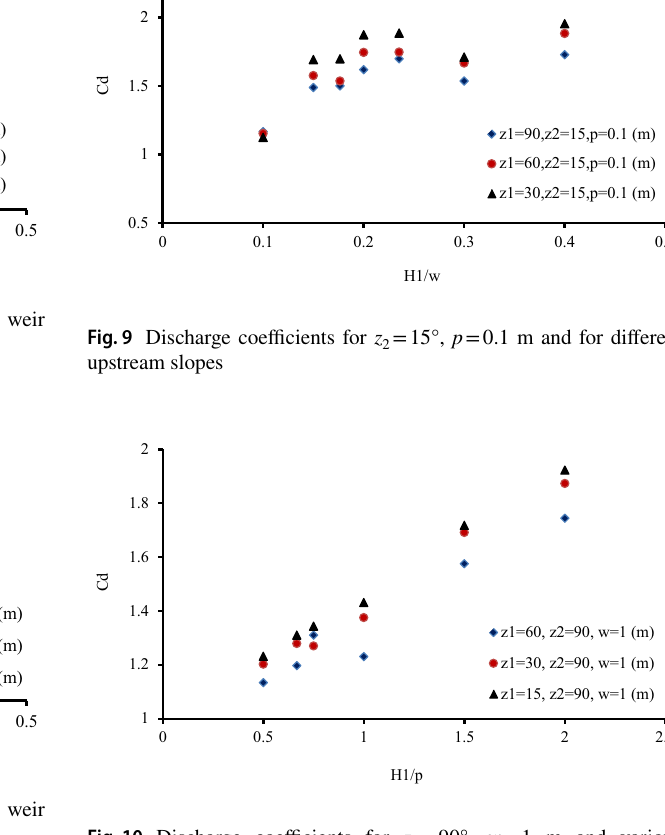
w = 1 m and various 2 = 90°,